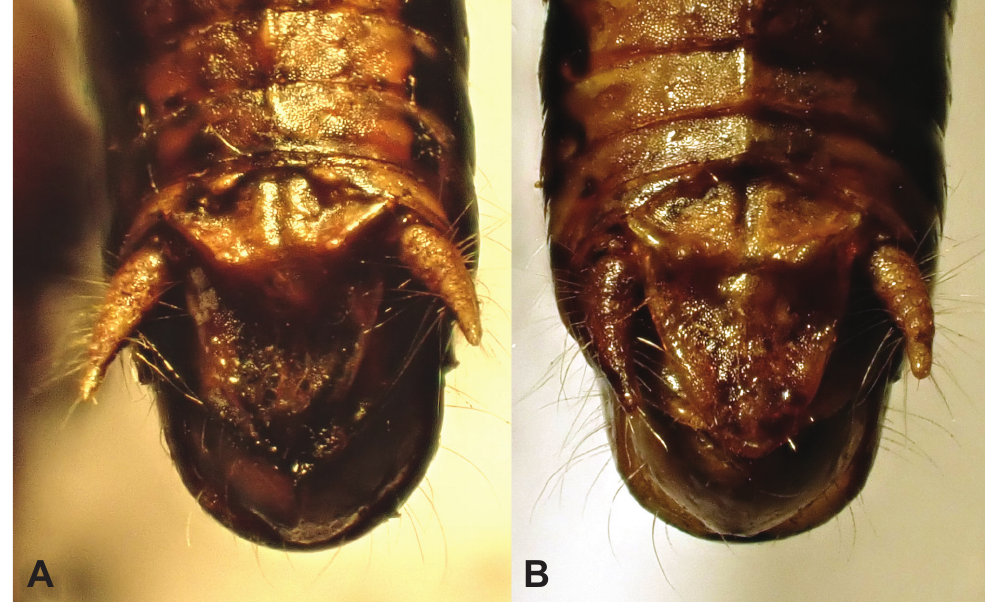
Fig. 4. Abdominal apices, dorsal view, of male Burttia caerulea sp. nov. ( A ) and B. sylvatica ( B ).